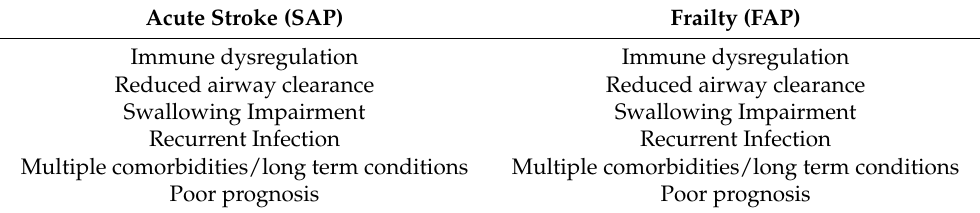
Table 1. Factors implicated in stroke-associated pneumonia and frailty-associated pneumonia. Acute Stroke (SAP) Frailty (FAP) Immune dysregulation Immune dysregulation Reduced airway clearance Reduced airway clearance Swallowing Impairment Swallowing Impairment Recurrent Infection Recurrent Infection Multiple comorbidities/long term conditions Multiple comorbidities/long term conditions Poor prognosis Poor